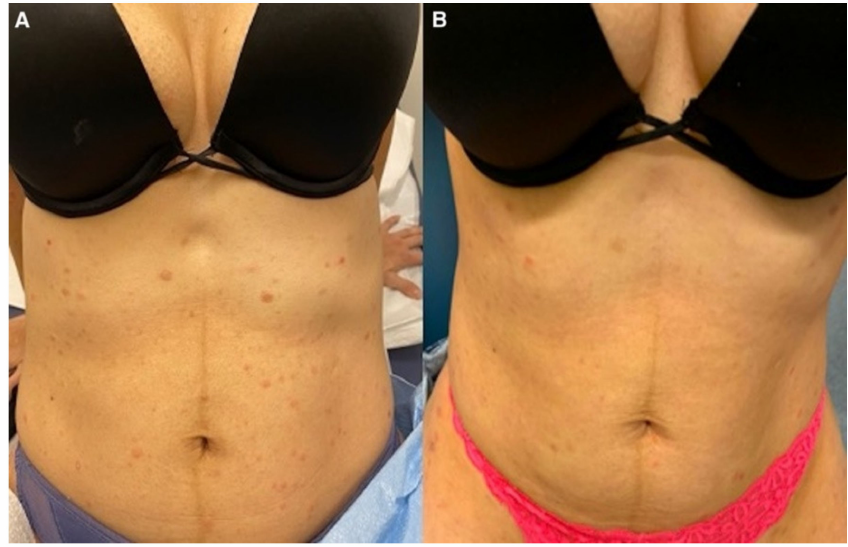
Figure 4. ( A ) Abdomen before medical management; ( B ) after azithromycin